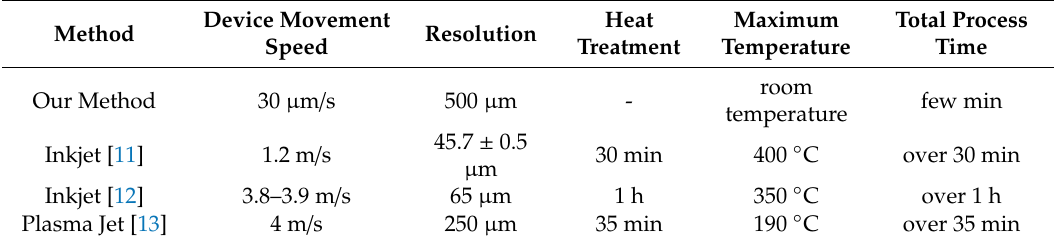
Table 1. Summary of the characteristics of our method and the other developed